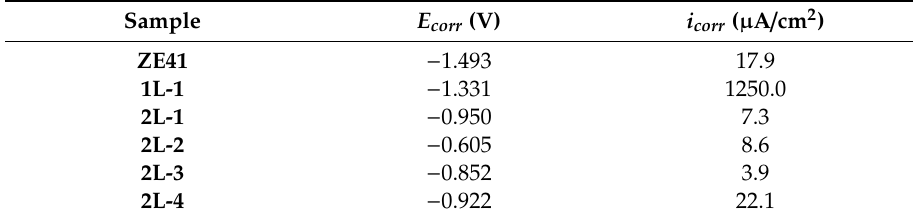
Table 6. Corrosion potential and current density obtained for the di ff erent specimens after 1 h of immersion in the